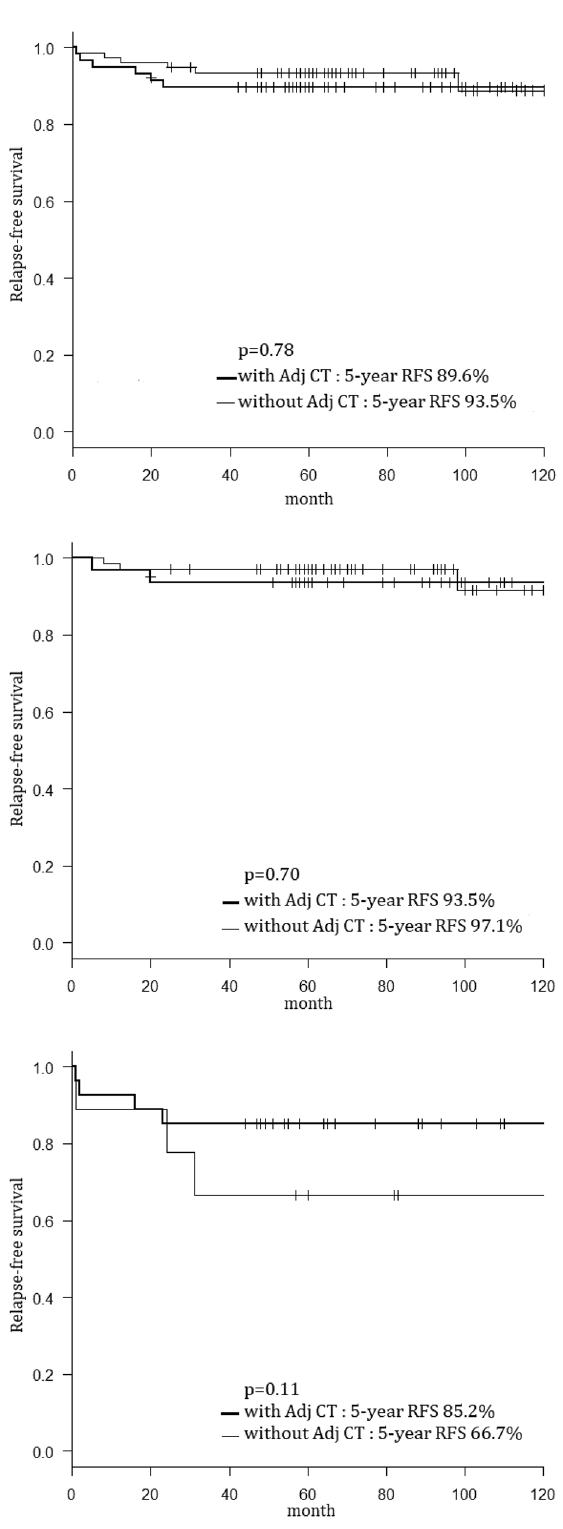
Figure 2. 1. Kaplan–Meier curves for the relapse-free survival rates of PPC stage IA endometrial cancer patients with and without adjuvant chemotherapy. PPC positive peritoneal cytology, Adj CT Adjuvant chemotherapy, RFS Relapse-free survival. 2. Kaplan–Meier curves for the relapse-free survival rates of PPC stage IA endometrial cancer patients with and without adjuvant chemotherapy (Type I). PPC positive peritoneal cytology, RFS Relapse-free survival. 3. Kaplan–Meier curves for relapse-free survival rates of PPC stage IA endometrial cancer patients with and without adjuvant chemotherapy (type II). PPC positive peritoneal cytology, RFS Relapse-free